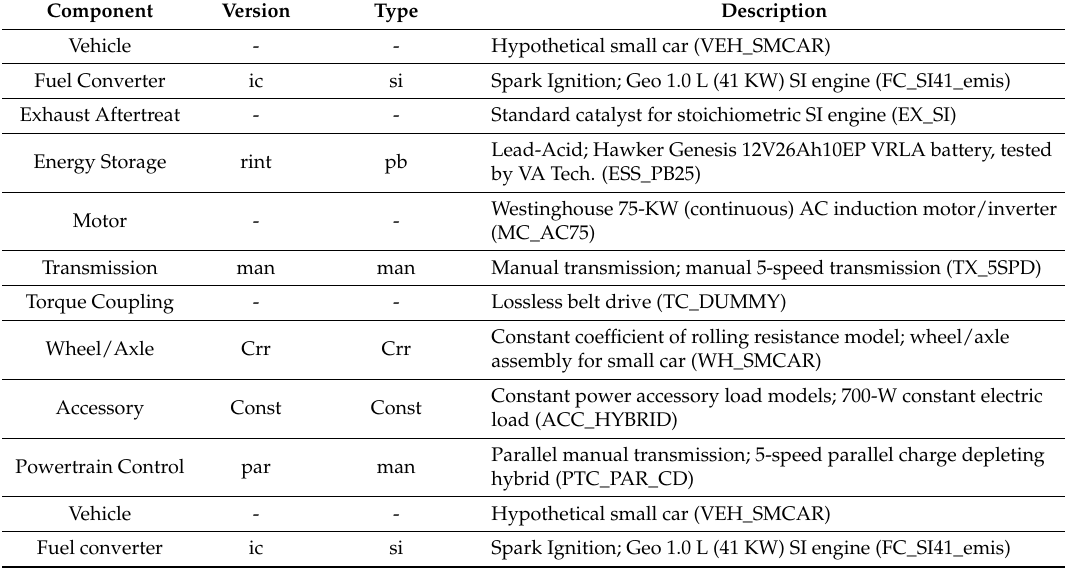
Table 5. Components for the parallel HEV model.